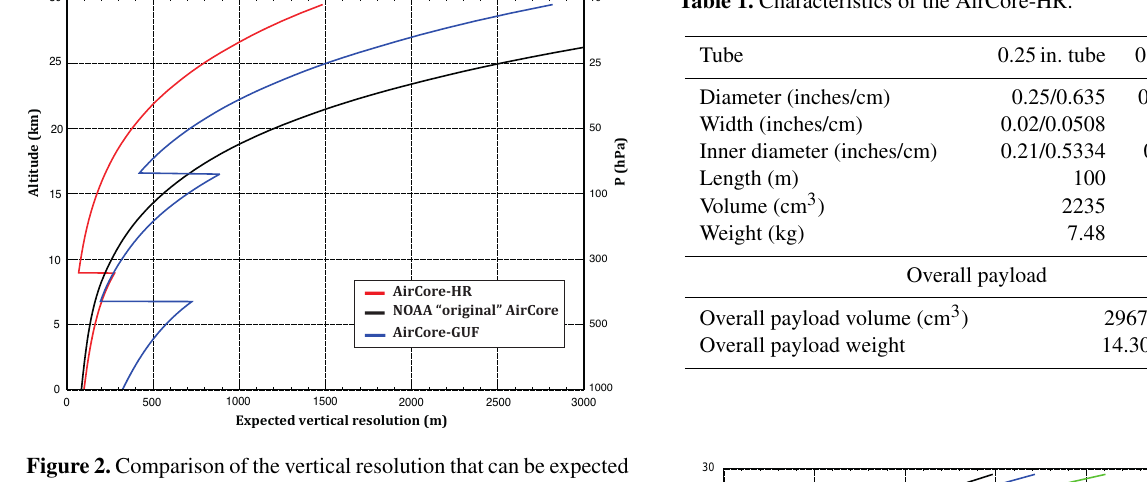
Table 1. Characteristics of the AirCore-HR.